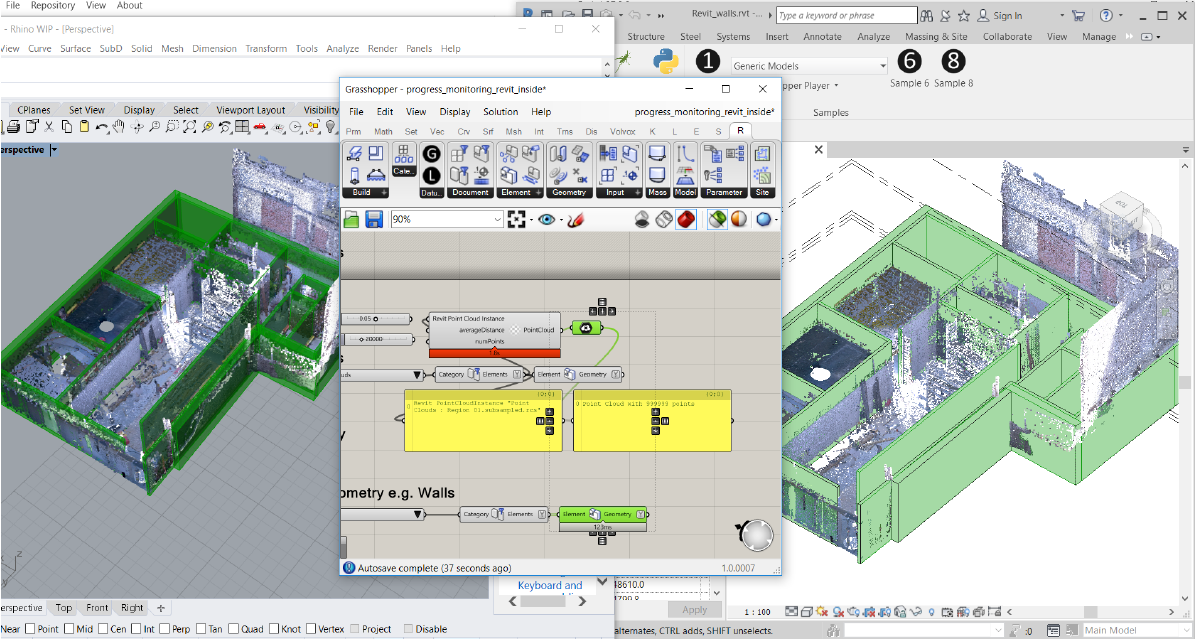
Figure 2: Overview implementation of the reconstruction algorithm. (1) the parameter extraction is performed in Rhino and Grasshop- per with developed components based on the Rhinocommon API and (2) the partial wall geometry and final wall geometry are con- structed directly inside Revit through the Rhino.Inside and Revit